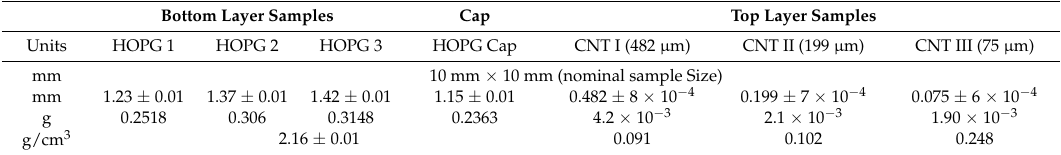
Figure 1. ( a ) Cartoon representation of the sample for a 2-layer thermal analysis model, ( b ) is a 3-D cartoon representation of the sample. Note: Figures are not drawn to scale. Table 1. Sample